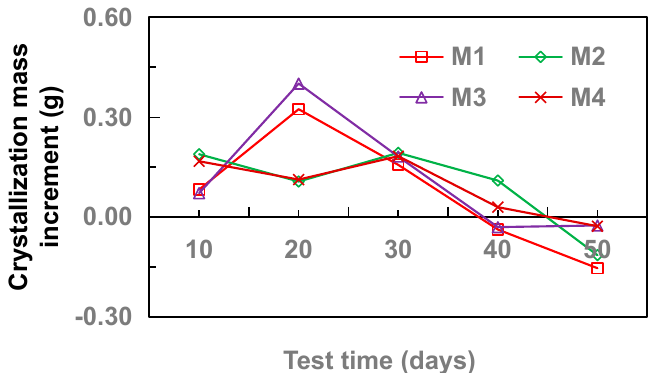
Figure 9. Variation of crystal quality with time.